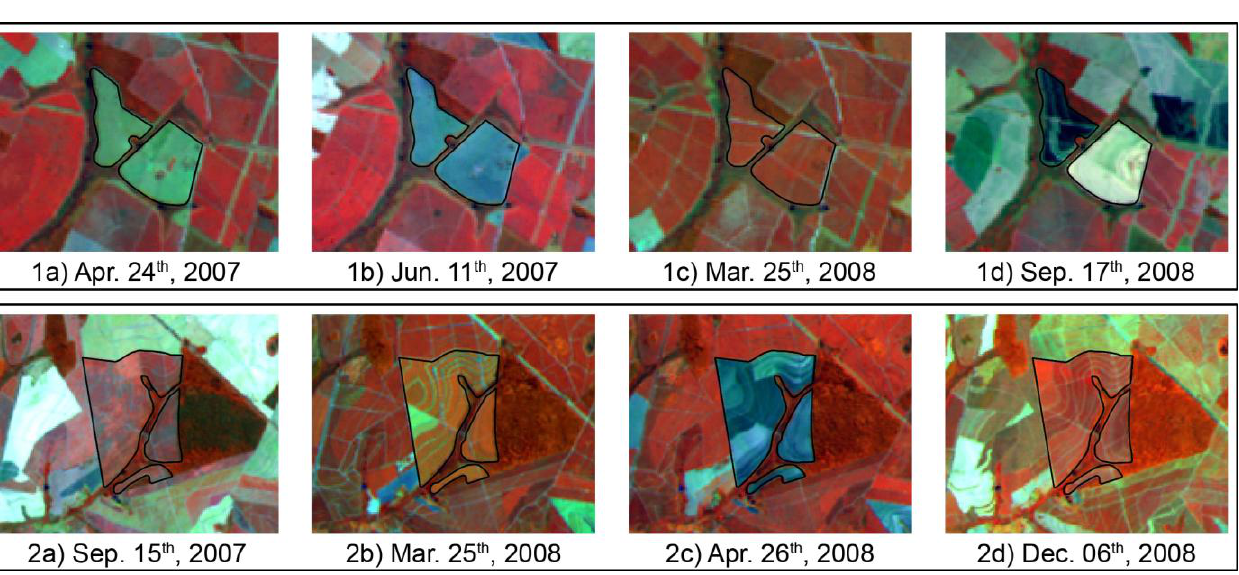
Figure 2. Multispectral [4(R)5(G)3(B)] and multi-temporal Landsat-5 images